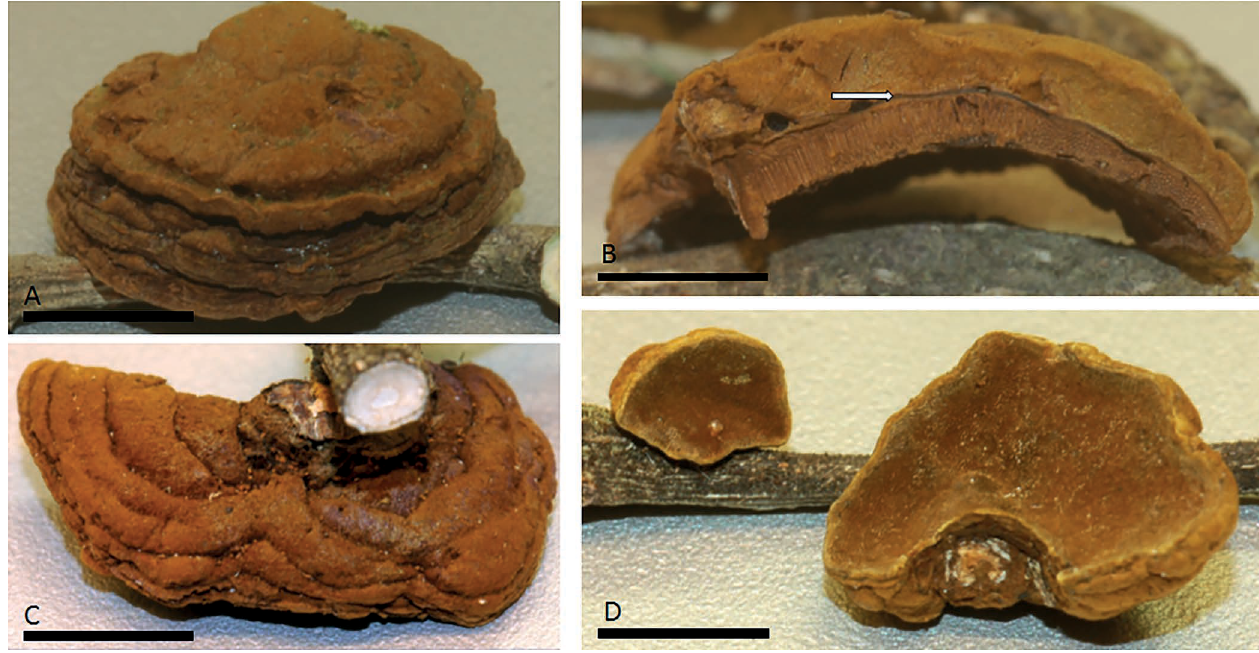
Figure 2 – Basidiomata of Phylloporia rinoreae . A . MUCL 56282, basidiome, upper view. B . MUCL 57328, section of basidiome, showing the black line above the context (arrow). C . MUCL 56284, basidiome, upper view. D . MUCL 57327, basidiome, view of the pore surface. Scale bars: A = 10 mm; B, C = 7 mm; D = 5